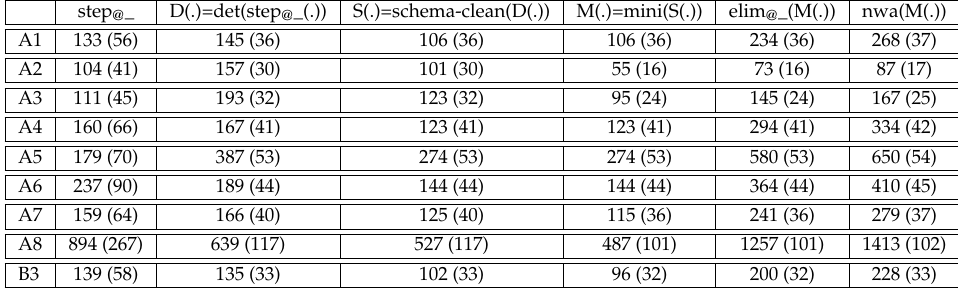
Figure 23. Optimized automata for derived stepwise automata compiled from NREs . Figure 25. Optimized automata for derived stepwise automata compiled from NREs